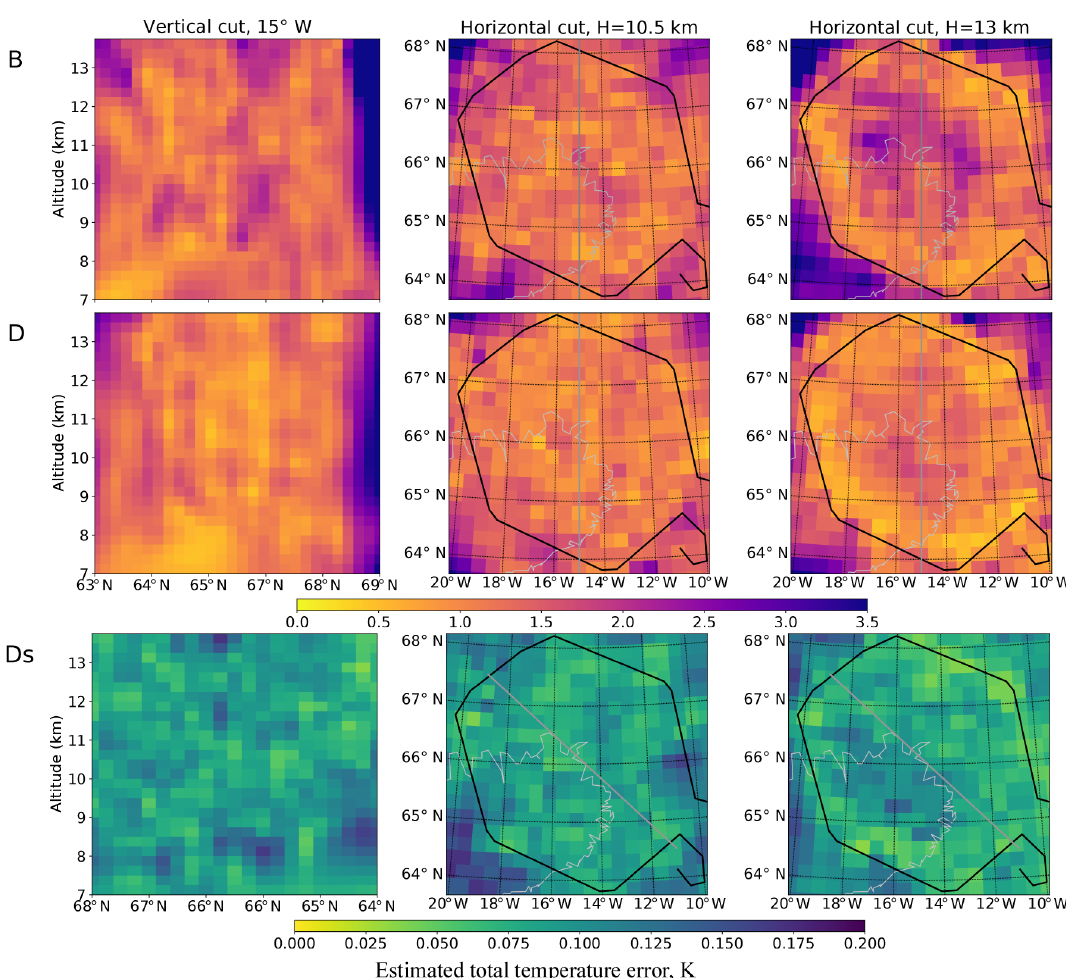
Figure 5. Panels B and D show the Monte Carlo estimate of the total temperature error the retrievals B and D would have if the measurements were real. Panel Ds shows an error estimate for the synthetic retrieval D (this assumes that unretrieved quantities, e.g. pressure, are known exactly). In columns 2 and 3, the black line is the flight path, the thick grey line is the position of the cut shown in the first column and the thin grey line is the